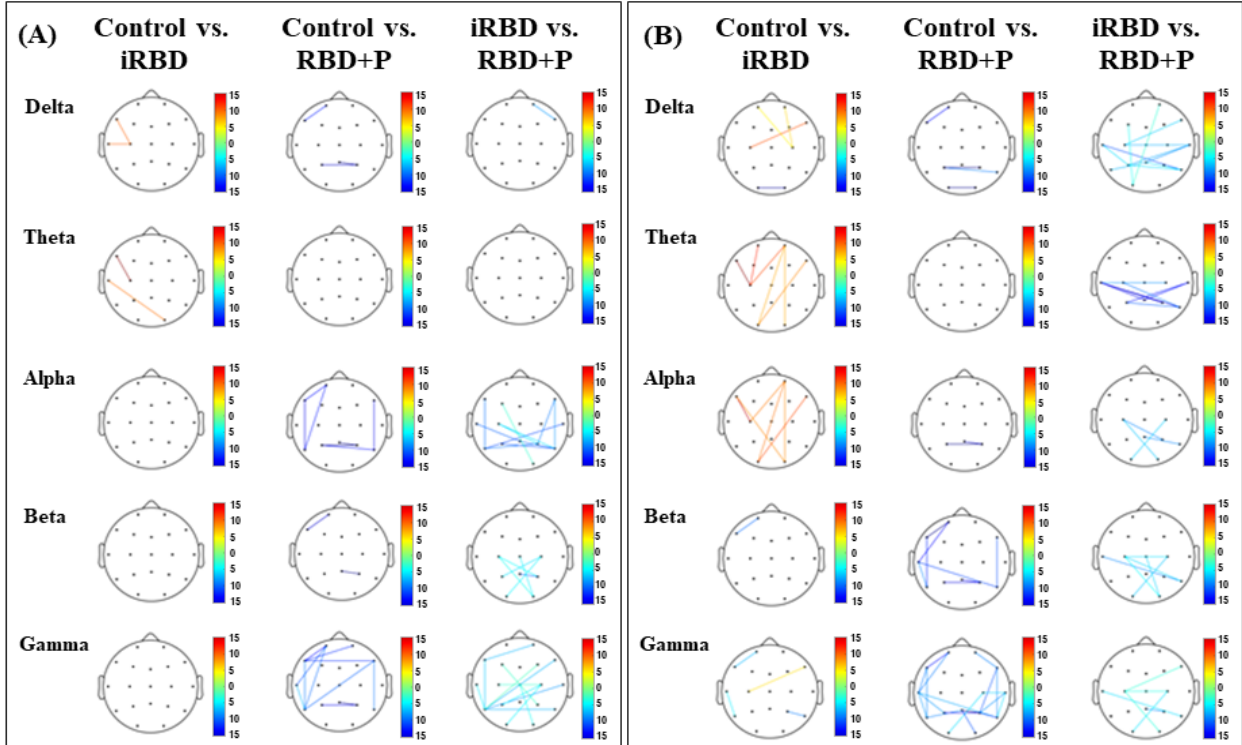
Figure 2. The CCC between electrode pairs shown with statistical significance at p < 0.05 during NREM N2 ( A ) and REM sleep ( B ). ( A ) During NREM N2 sleep stage, the iRBD group revealed a lower alpha and gamma band CCC in frontal, temporal, and parietal areas compared with control group, whereas higher alpha band coherence in frontal, central, and temporal areas, higher beta band CCC in parietal and occipital areas, compared with RBD+P patients. In RBD+P patients, CCC in frontal, central, and temporal alpha power, and CCC in frontal, central, temporal gamma power during NREM2 sleep were lower than controls, and also CCC in frontal, central, and temporal alpha power, CCC in central, parietal, and occipital beta power, as well as CCC in frontal, central, temporal, and occipital gamma power were lower than the iRBD group. ( B ) During REM sleep, iRBD patients showed a considerably higher CCC in theta and alpha bands in frontal, central, and occipital areas compared with control subjects. The RBD+P group showed a lower CCC in beta band in frontal and temporal areas, and lower CCC in gamma band in frontal, temporal, parietal, and occipital areas than the control group. In addition, the RBD+P patients had a lower delta, theta, alpha, beta, and gamma band CCC in central, temporal, parietal, and occipital areas compared with iRBD patients. Abbreviation: CCC, corticocortical coherence; NREM, non-rapid eye movement; REM, rapid eye movement; iRBD, idiopathic RBD; RBD+P, RBD with Parkinsonism.